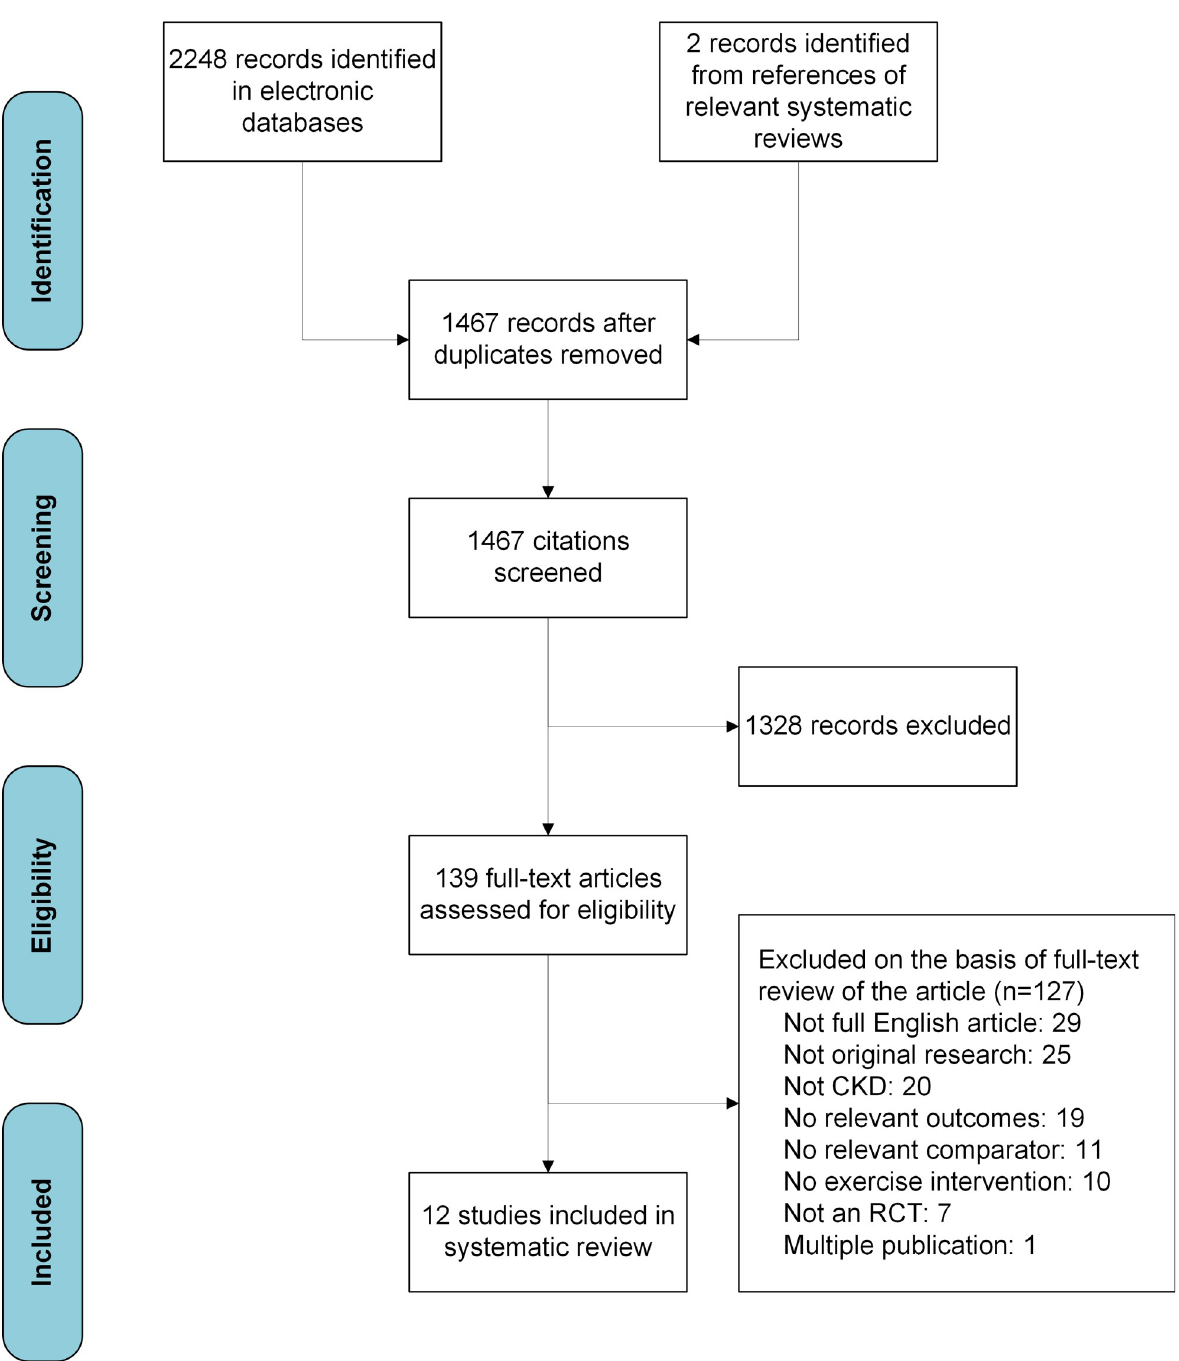
Fig 1. Preferred Reporting Items for Systematic Reviews and Meta-analyses (PRISMA) flow diagram for the systematic review and meta- analysis. CKD chronic kidney disease, RCT randomized controlled trial. third-party outcome assessment. When we removed this trial from the meta-analysis, the MD Publication bias. The funnel plot was mildly asymmetric about the vertical dashed line (the random-effects pooled estimate) likely indicating heterogeneity caused by the two strata